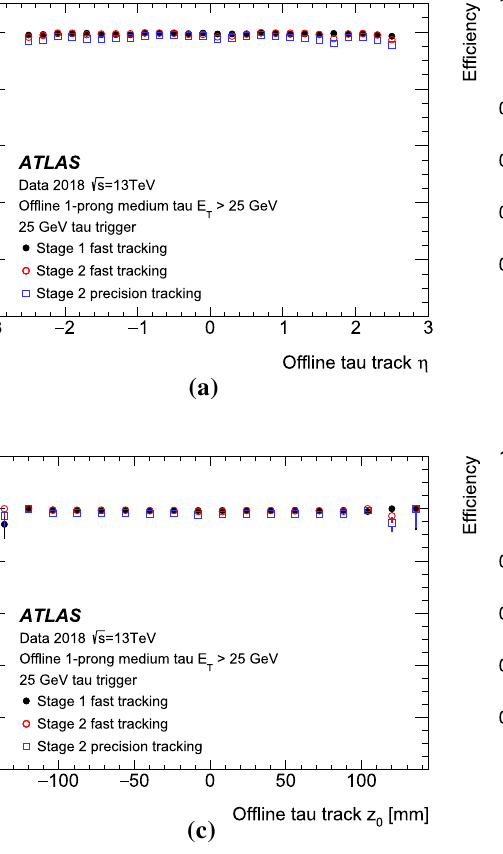
Fig. 32 The track finding efficiency of the ID trigger for tracks from tau decays with p T > 1GeV. The efficiency is evaluated for the 25GeV tau performance trigger which does not use ID tracking information for the selection. The efficiency is shown as a function of a offline track η ,